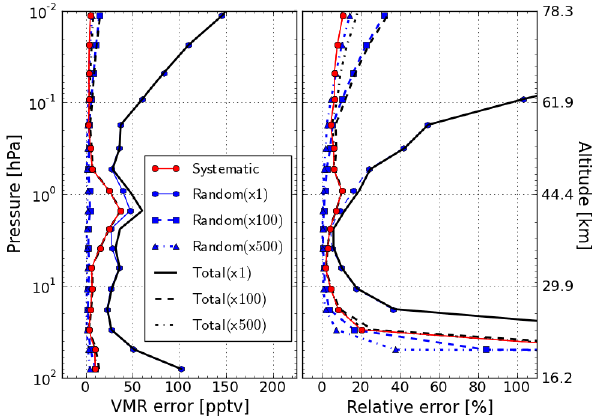
Fig. 9. Same as Fig. 4 except for the total error. Total error in the ClO retrieval for averaging of N profiles ( N =1, 100 and 500). Red: Systematic error. Blue: Random error when averaging N profiles. Black: Total error when averaging N profiles.